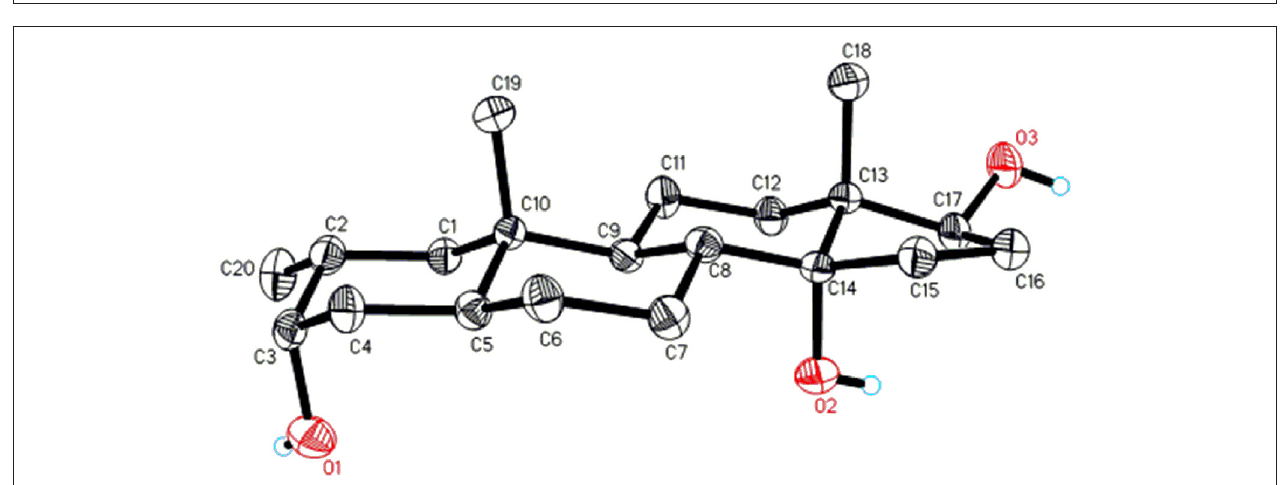
FIGURE 5 | Computer-generated ORTEP drawing of final X-ray model of compound 2 . Color codes: carbon, black; hydrogen, white; oxygen, red.